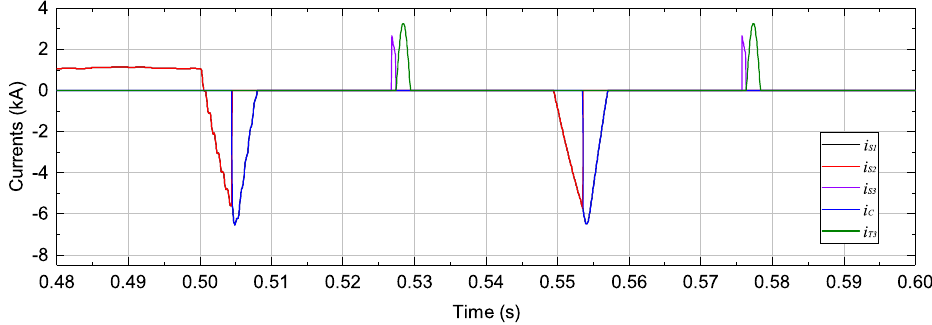
Figure 14. Overall currents on the switches of HCB 2.